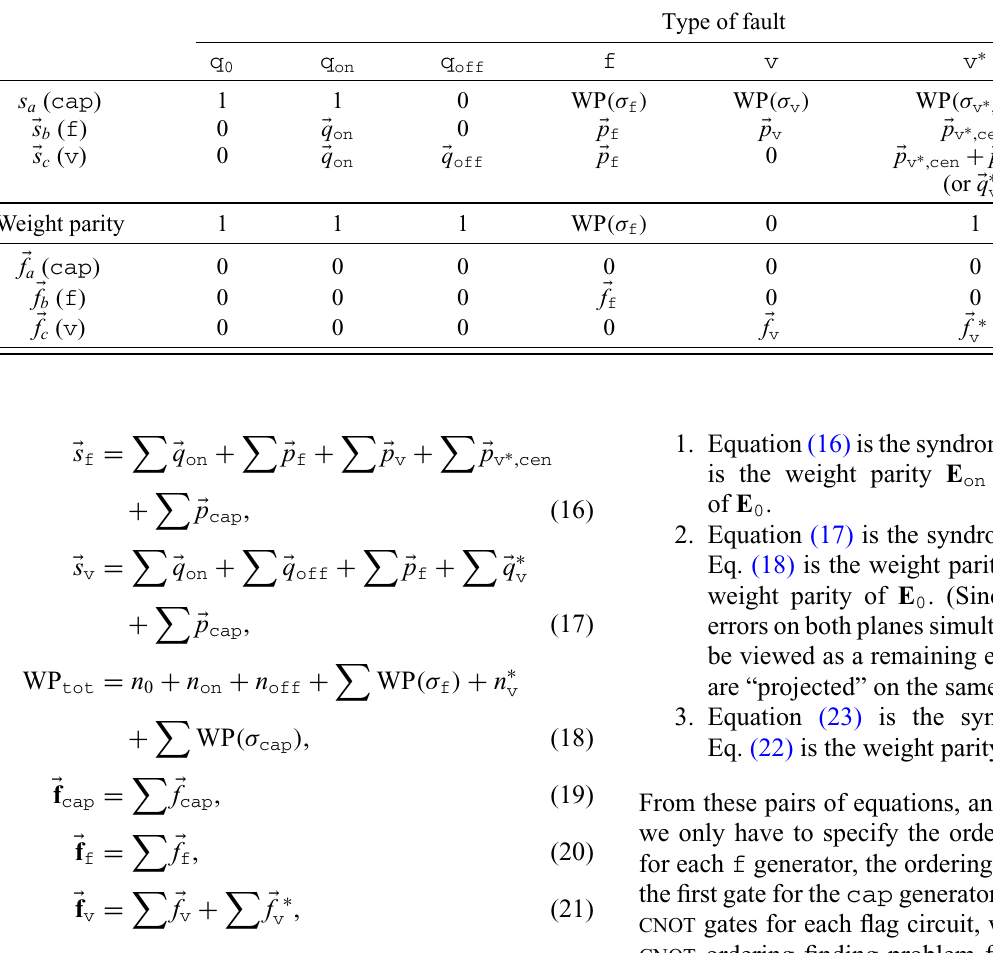
(cid:6) (cid:6) (cid:6) (cid:6) f = ( f a , f b , f c ) corresponding to a single fault of each type that